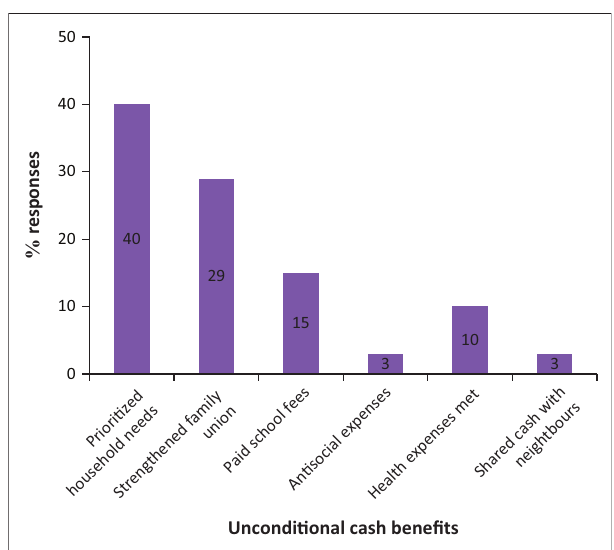
FIGURE 1: Benefits of receiving unconditional cash